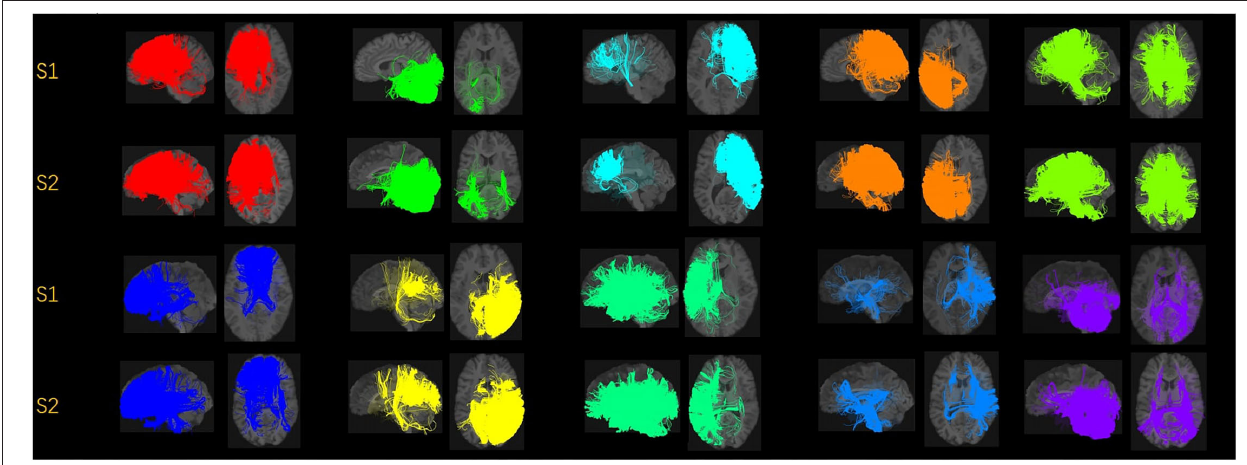
FIGURE 2 | Visualization of the fiber clusters of two randomly chosen subjects. Rows 1 and 3 show clusters 1 through 10 for subject S1, while rows 2 and 4 show clusters 1 through 10 for subject S2. It shows the heterogeneity of their brains and connectomes.